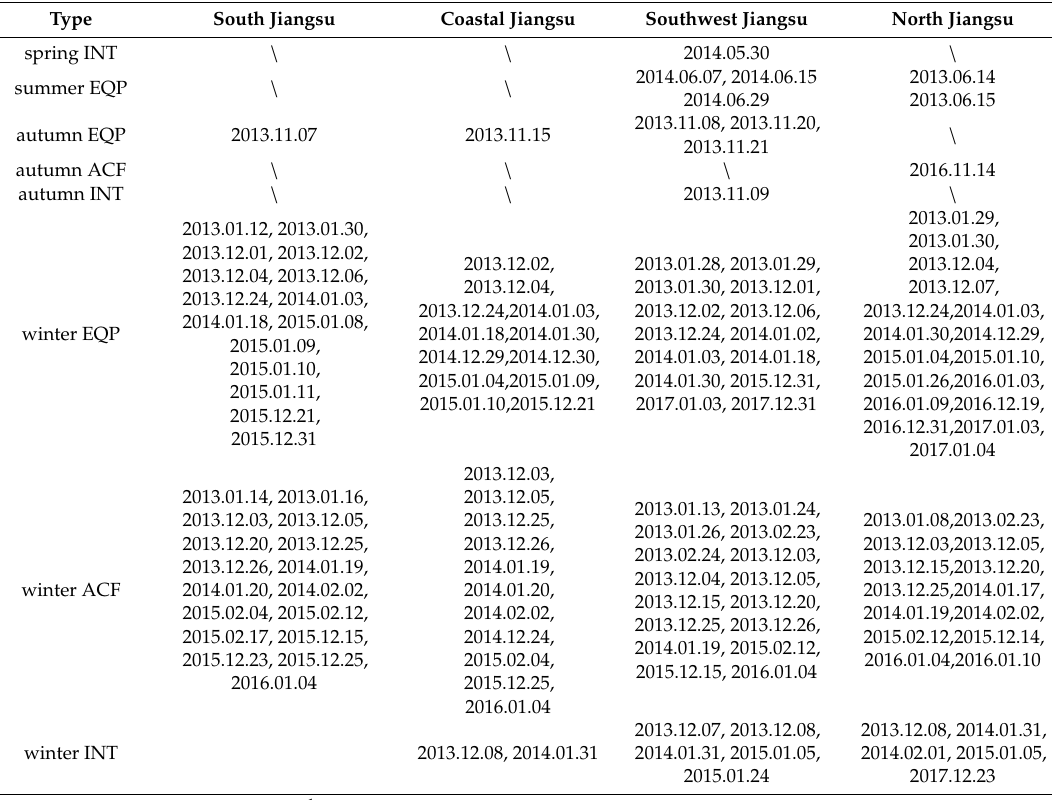
(Table 1). In terms of four seasons and surface synoptic flow patterns, eight types were obtained: (a) spring INT, (b) summer EQP, (c) autumn EQP, (d) autumn ACF, (e) autumn INT, (f) winter EQP, (g) winter ACF, (h) winter INT. Table 1. RPHPDs (regional PM 2.5 pollution days) during 2013–2017 1 . (equalized pressure (EQP), advancing edge of a cold front (ACF) and inverted trough of low pressure